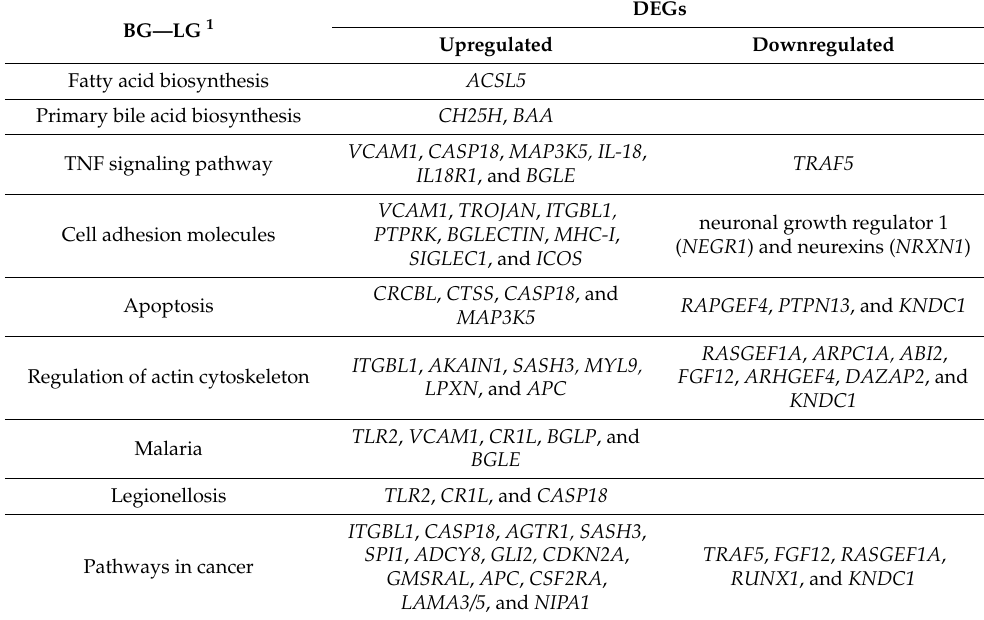
Figure 7. Enriched GO terms for the LG and the PLG. The vertical axis indicates GO terms, and the horizontal axis represents the number of DEGs. The numbers of enriched genes in each GO term are shown in the biological process (red color) area, cellular component (blue color) area, and molecular function (green color) area. LG, environment enriched with a litter materials group; PLG, environment enriched with perches and a litter materials group. Table 1. DEGs enriched in Kyoto Encyclopedia of Genes and Genomes (KEGG) pathways in the BG and the